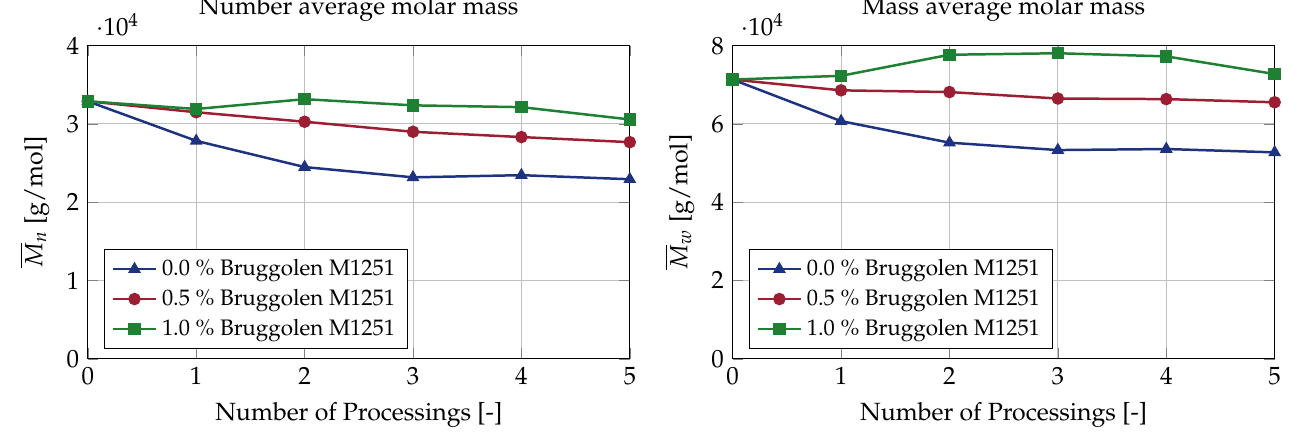
Figure 3. Number and mass-average molar mass over five extrusion cycles for different concentrations of the chain